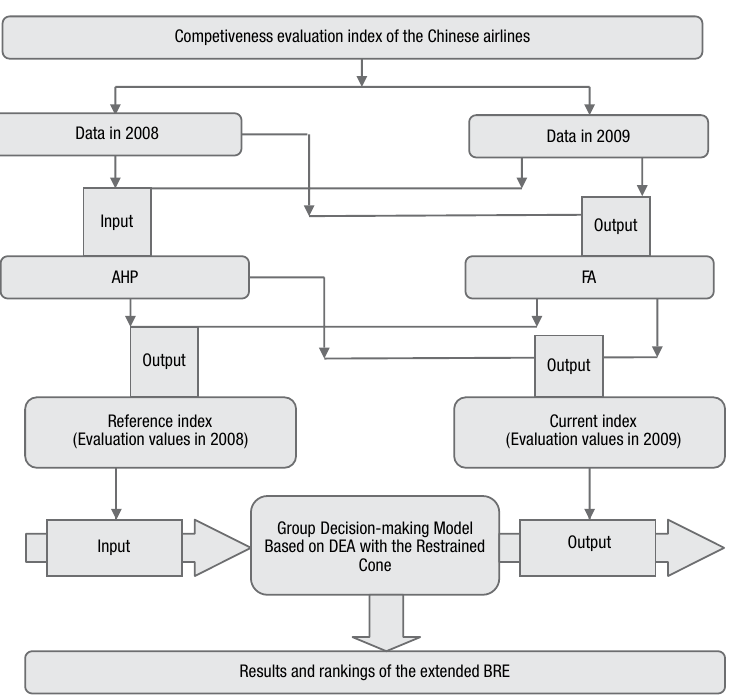
Fig. 1. Extended BRE model for the competiveness evaluation of Chinese